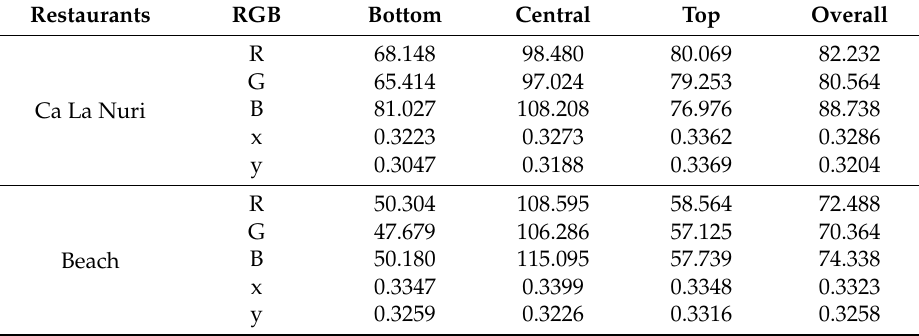
Table 5. RGB and xy (CIE 1931) chromaticity values of the second workplane (the face) for each restaurant. Restaurants RGB Bottom Central Top